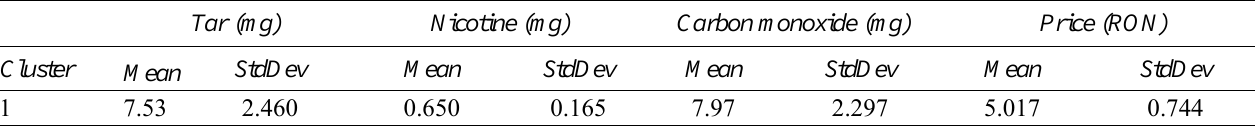
Table 8: Two-steps cluster analysis: centroids Tar (mg)